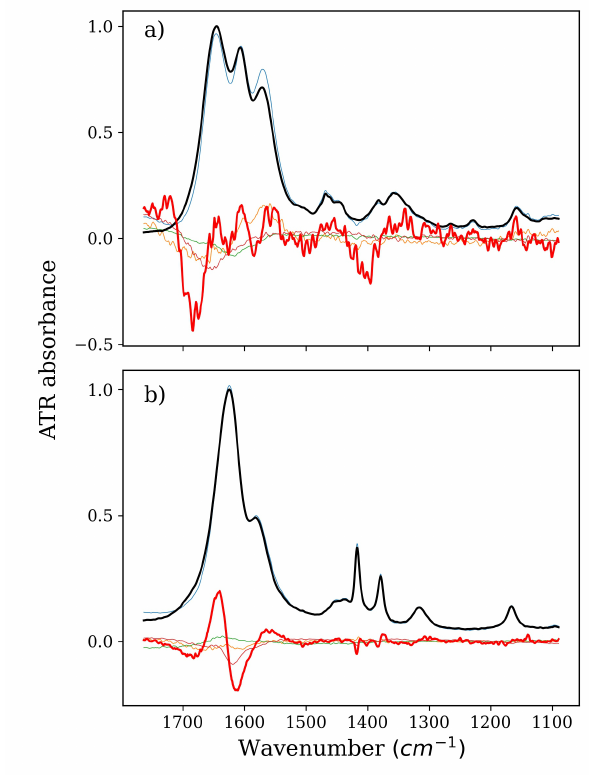
Figure 4. Spectra of pure NBU or NMA solution (thick black lines), derivatives (thick red lines), and isolated spectra of factors from a series devoid of ( a ) water and NMA or ( b ) water and NBU (all other thin lines). Part ( a ), therefore, denotes NBU, and Part ( b ) denotes NMA, both corresponding to the green and magenta series in Figure 6b,